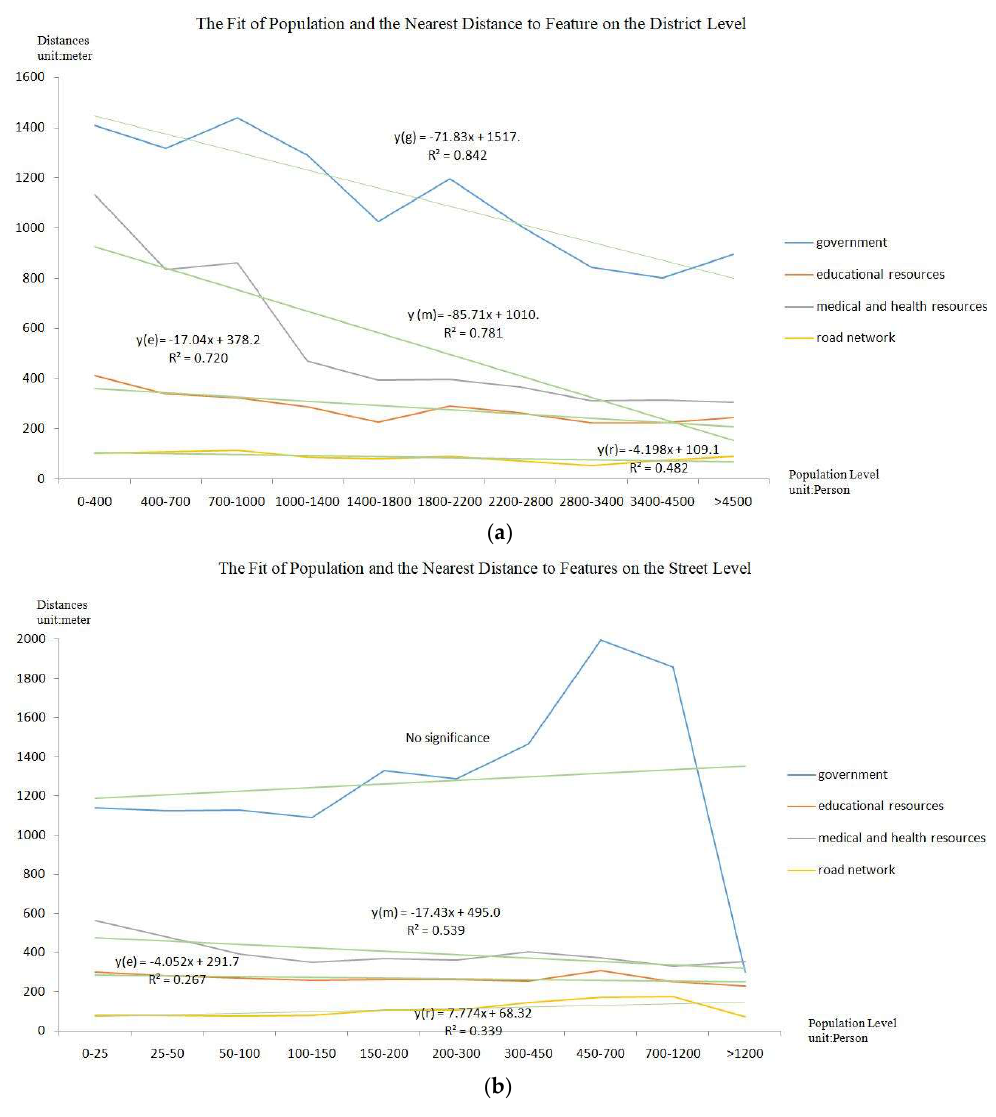
Figure 9. The Fit of Population and the Average Nearest Distance to Features (( a ) result on the district level; and, ( b ) result on the street level).